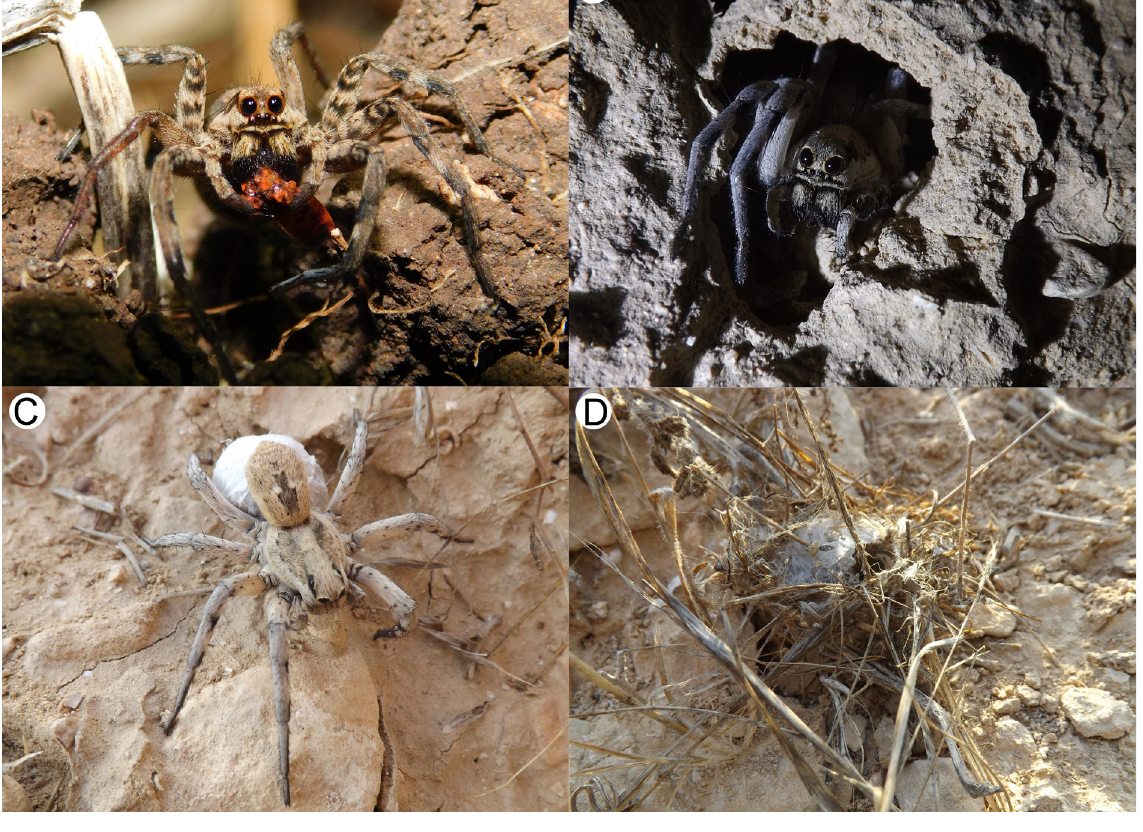
Fig. 16. Lycosa piochardi Simon, 1876, natural history. A . Feeding on Pyrrhocoris apterus (Linnaeus, 1758), Mt. Gilboa. B . At the opening of a turretless burrow, central Negev. C . Female with egg sac, Midreshet Ben-Gurion. D . Turreted burrow sealed with silk, Midreshet Ben-Gurion. Photos by I. Armiach